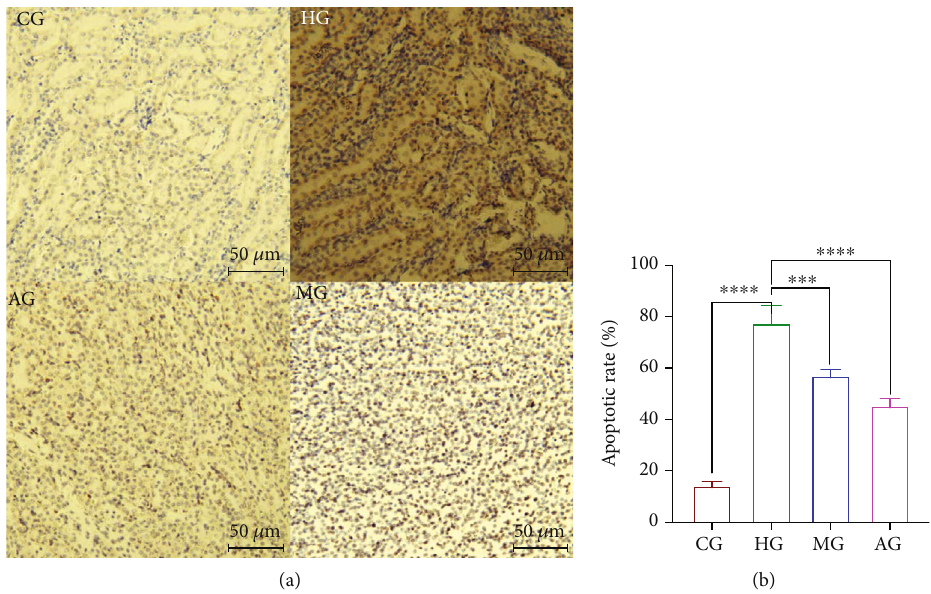
Figure 4: Terminal deoxynucleotidyl transferase dUTP nick end labeling (TUNEL) analysis of apoptotic cells in kidney tissue. (a) The imaging results using TUNEL Cell Apoptosis Detection Kit. (b) Apoptotic rate measured by the percent of TUNEL-positive cells. Magni fi cation: 100x; scale bar: 50 μ m. n = 3 for each group, and ∗∗∗ P < 0 : 001 and ∗∗∗∗ P < 0 : 0001 vs. the HG